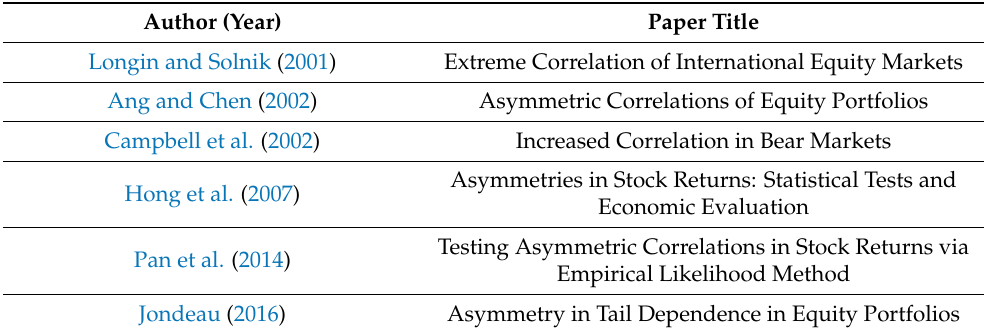
Table 1. Selected work on existence of asymmetric